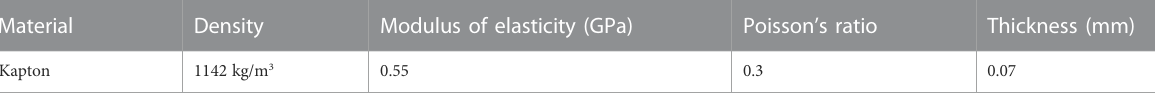
TABLE 4 Material parameters of in fl atable wing.